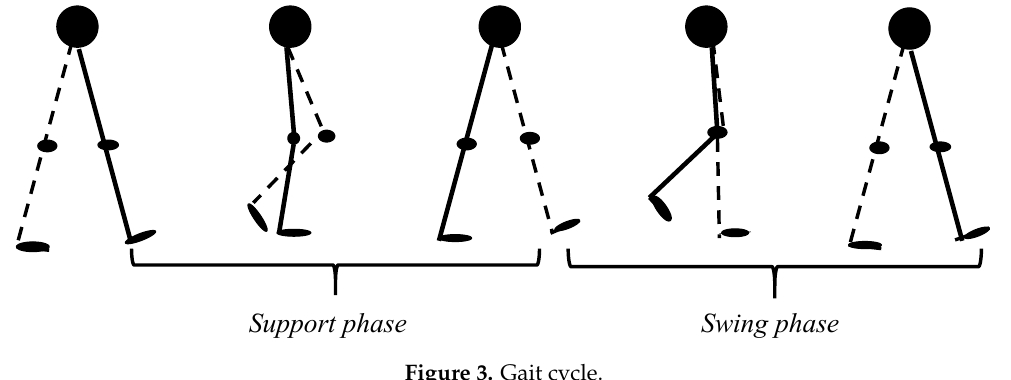
Figure 3. Gait cycle.